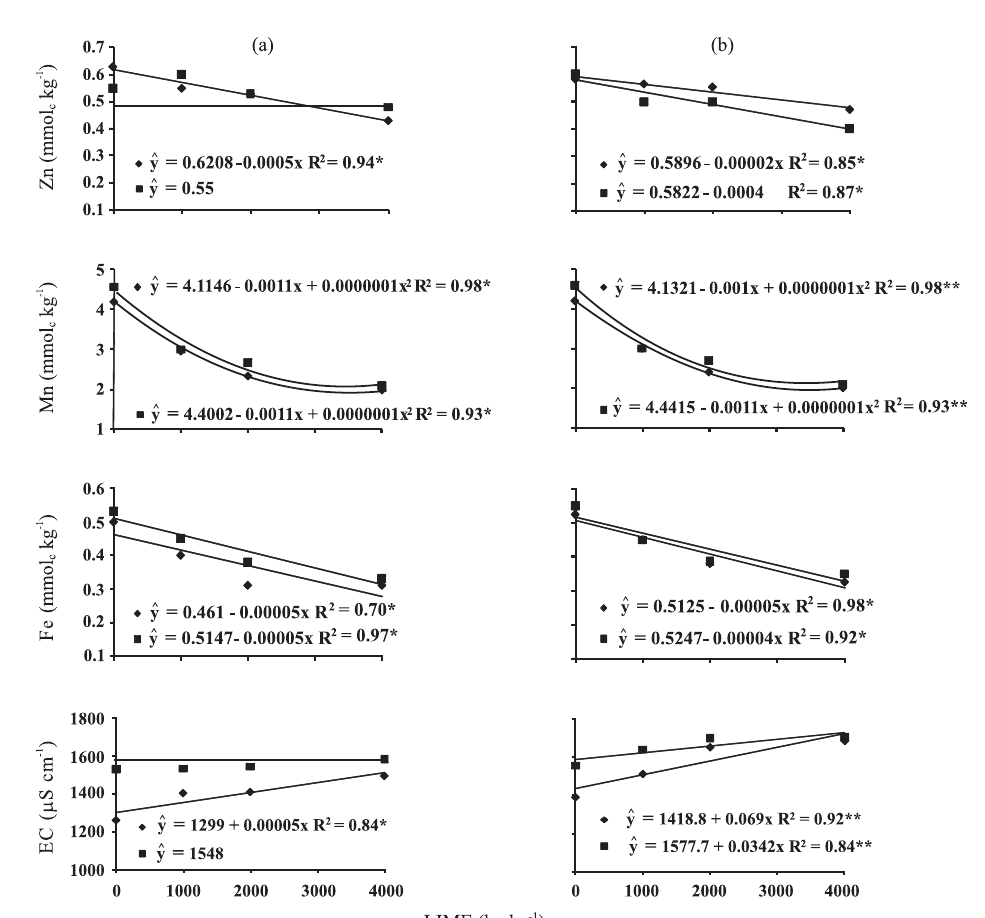
Figure 2. Contents of water-soluble zinc, manganese and iron and electrical conductivity (EC) in plant extracts of flowering peanut, as related to surface liming . ( ) without gypsum and ( ) with gypsum in 2004/2005 (a) and 2005/2006 Table 3. Contents of water-soluble nutrients and electrical conductivity (EC) in the white oat extract at flowering as related to application or non-application of gypsum to the soil surface in 2004/2005 and 2005/2006